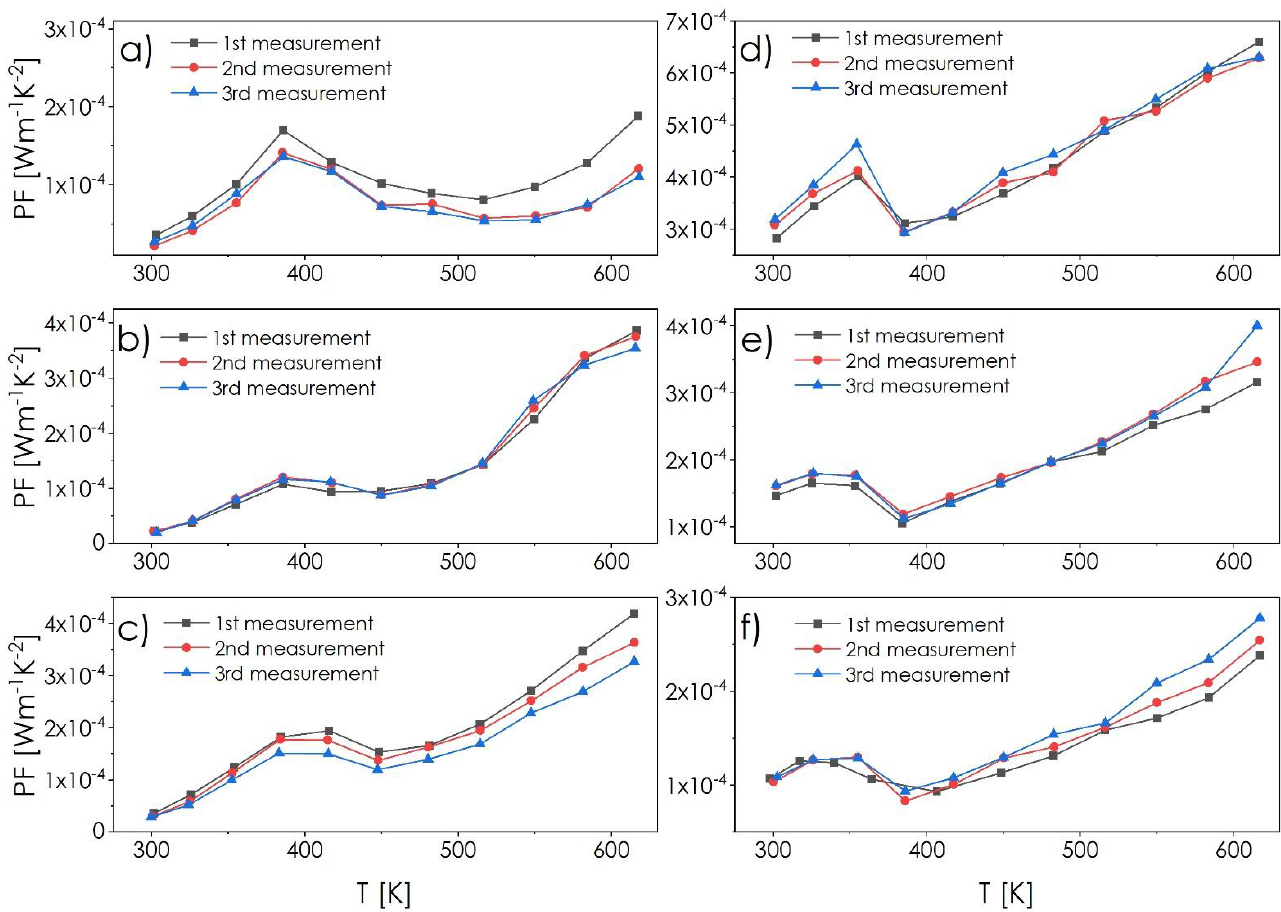
Figure 7. Power factor as a function of temperature determined on the basis of conductivity and Seebeck coefficient measurements (PF = σα 2 ) for composite ingots: ( a ) CSS1, ( b ) CSS5, ( c ) CSS10, ( d ) CSE1, ( e ) CSE5, ( f ) CSE10.